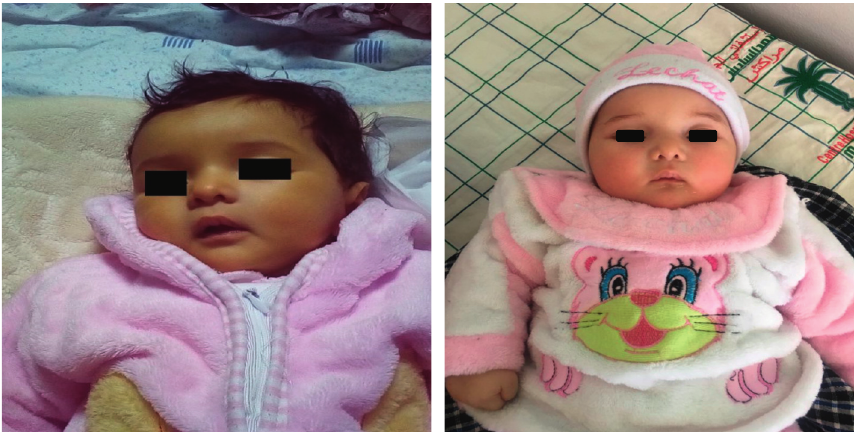
Figure 2: After 3 months of follow-up, the jaundice disappeared